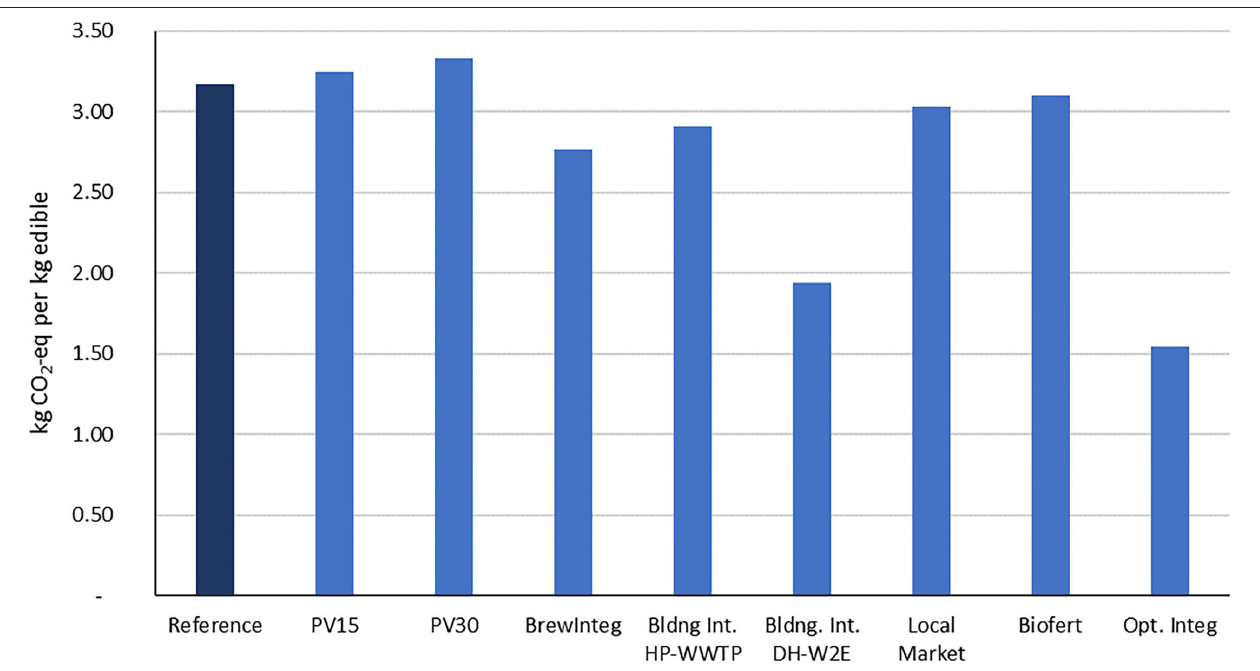
FIGURE 5 | GHG emissions per kg edible plant for all scenarios. Results are shown in kg CO 2 -eq per kg edible portion of the